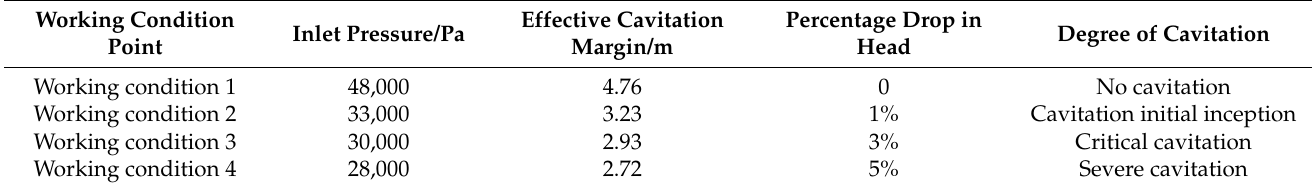
Table 3. Calculated working points.